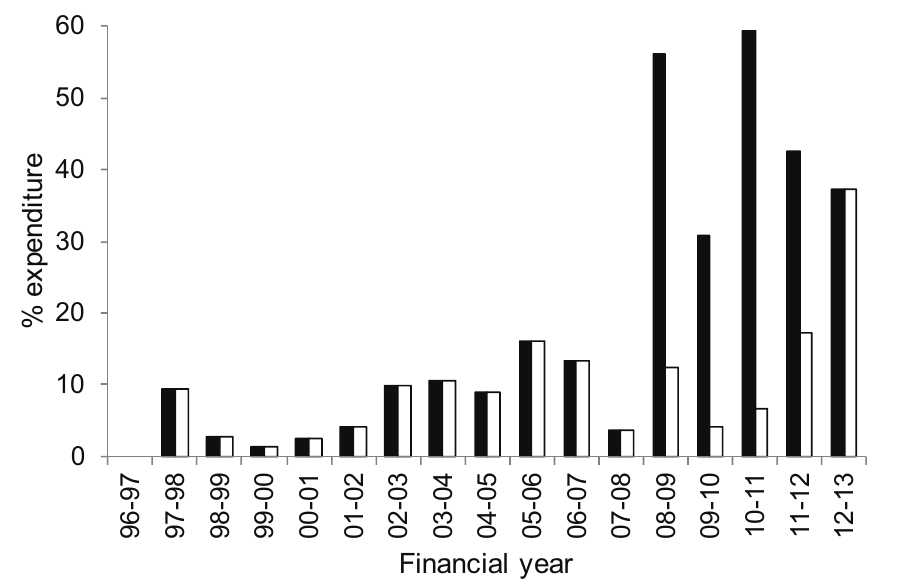
Figure 3. Percentage of total expenditure of federal grants per financial year used for invasive species management with base-level funding included (black) and excluded